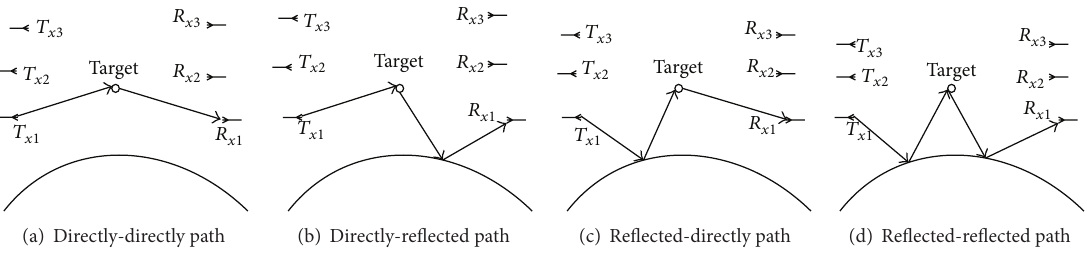
Figure 2: Multipath MIMO